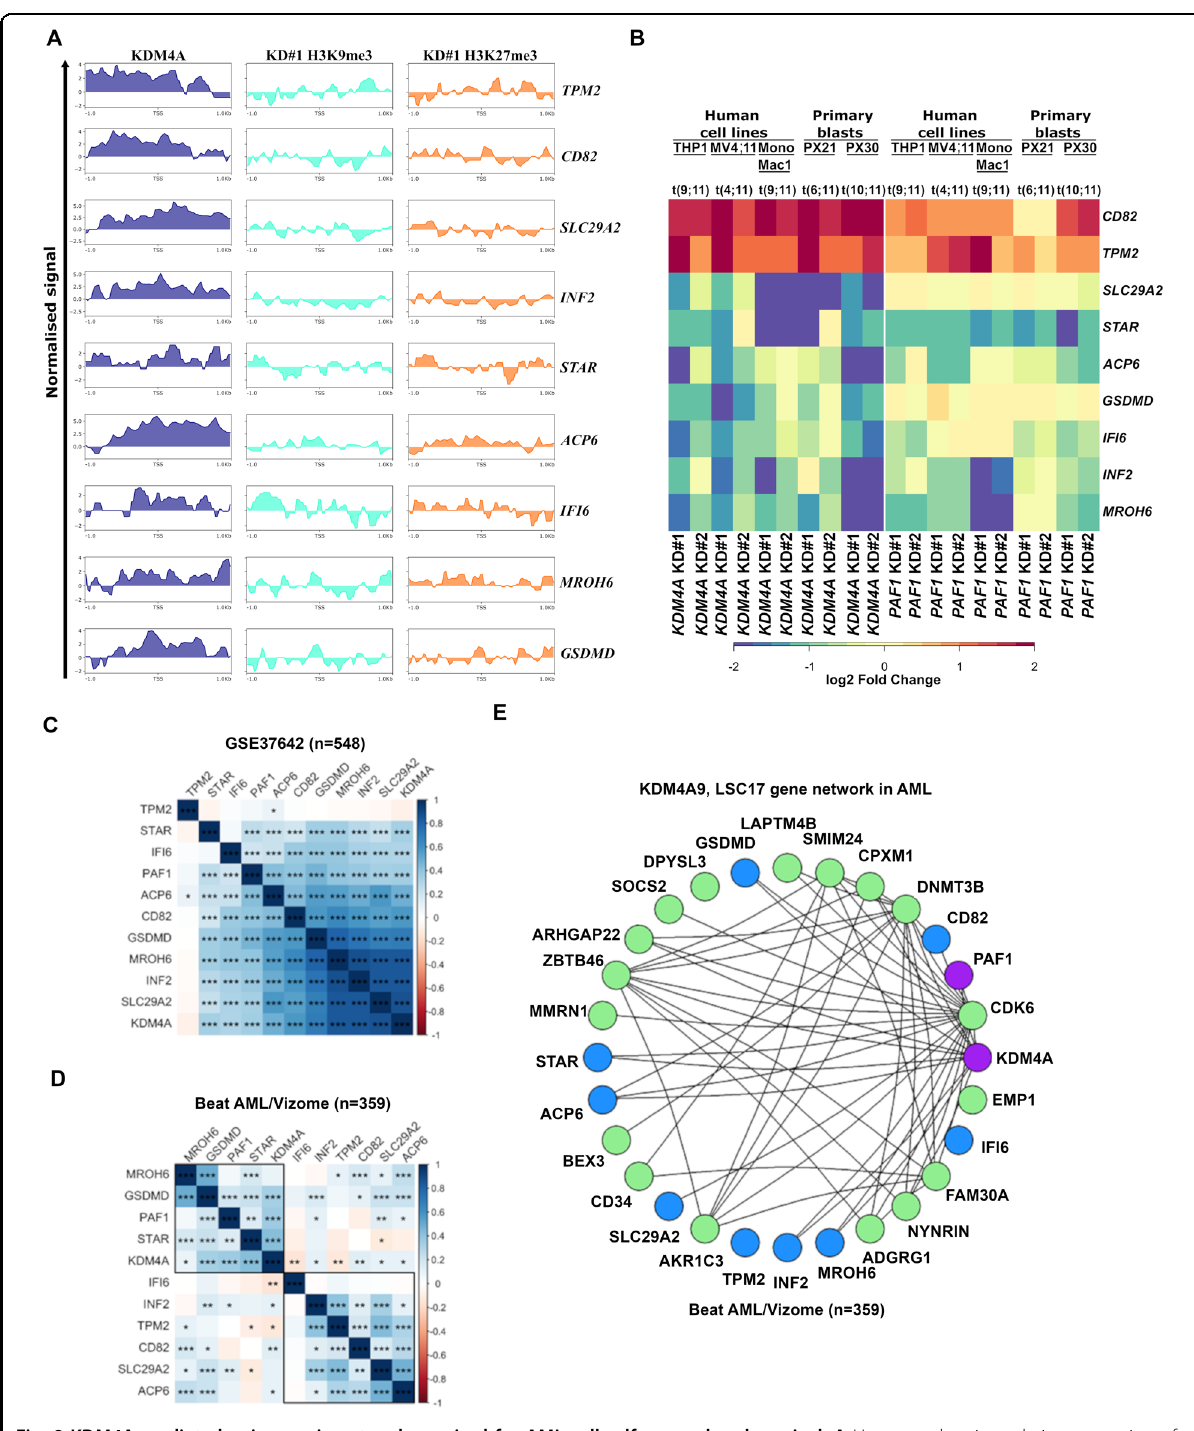
Fig. 8 KDM4A-mediated epigenomic network required for AML cell self-renewal and survival. A Heatmap showing relative expression of KDM4A-9 signature genes as determined by QPCR in the indicated human MLLr-AML cell lines and AML primary cells following KDM4A KD or PAF1 KD in comparison with NTC control cells ( n = 3). B Input normalized ChIP-seq coverage tracks showing KDM4A ChIP signal in WT THP1 cells and H3K9me3/H3K27me3 ChIP signal normalized to NTC in KDM4A KD THP1 cells at KDM4A-9 signature genomic loci ( + / − 1 kb TSS). The normalized signal shown is the log 2 ratio of read counts compared against input control. C – D Correlation matrices showing the Pearson correlation coef fi cients for KDM4A , KDM4A -9 genes, and PAF1 gene expression in GSE37642 ( C ) and Beat AML/Vizome ( D ) AML datasets. Signi fi cance determined by t -test; * p < 0.05, ** p < 0.01, *** p < 0.001, **** p < 0.0001. E KDM4A , PAF1 , KDM4A-9 (in blue), and LSC17 (in green) gene network showing the topological overlap between genes as detected from 262 AML samples (Beat AML) (the corresponding topological overlap matrix (TOM) ≥ 0.05 between nodes. Genes with high topological overlap matrix (TOM) measure (TOM ≥ 0.05) have related